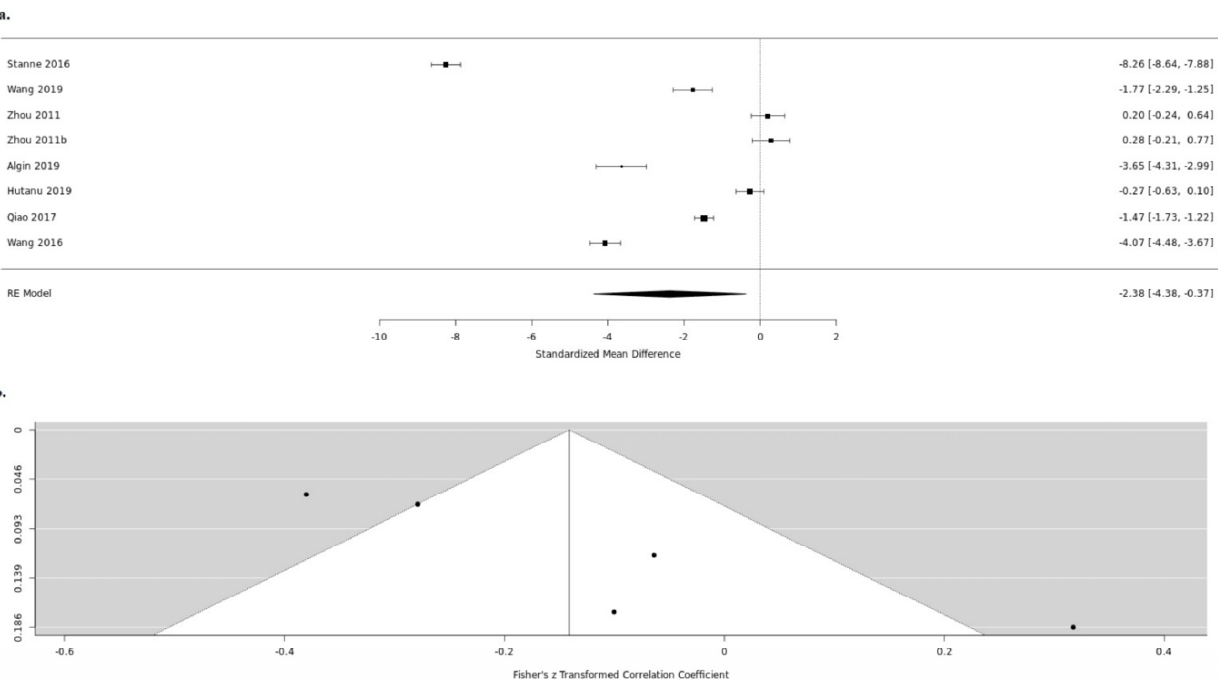
Figure 6. Sensitivity analysis serum BDNF and infarct stroke volume.